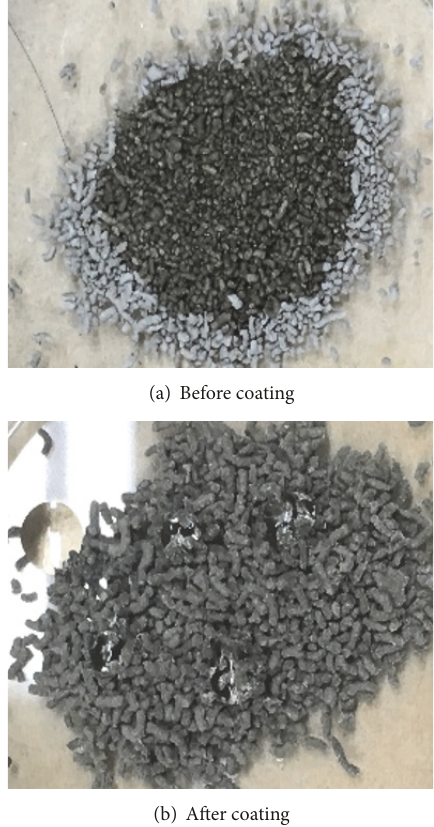
Figure 14: Formation of wall materials according to surface